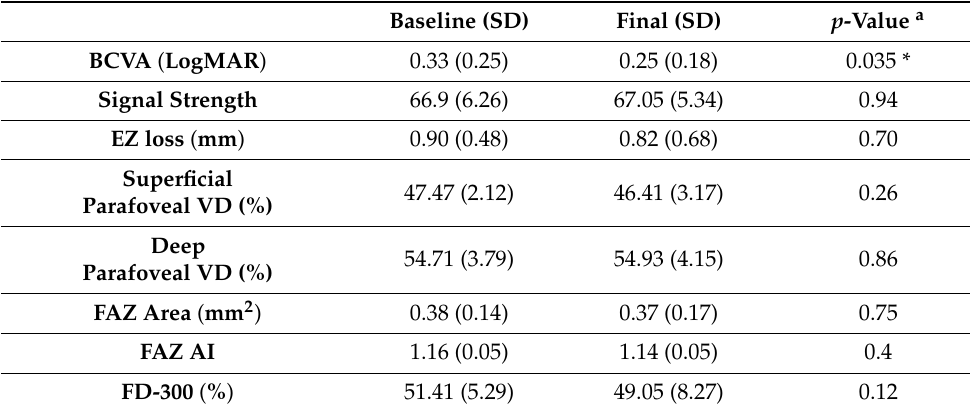
Table 2. Differences in Baseline and Final OCTA Parameters